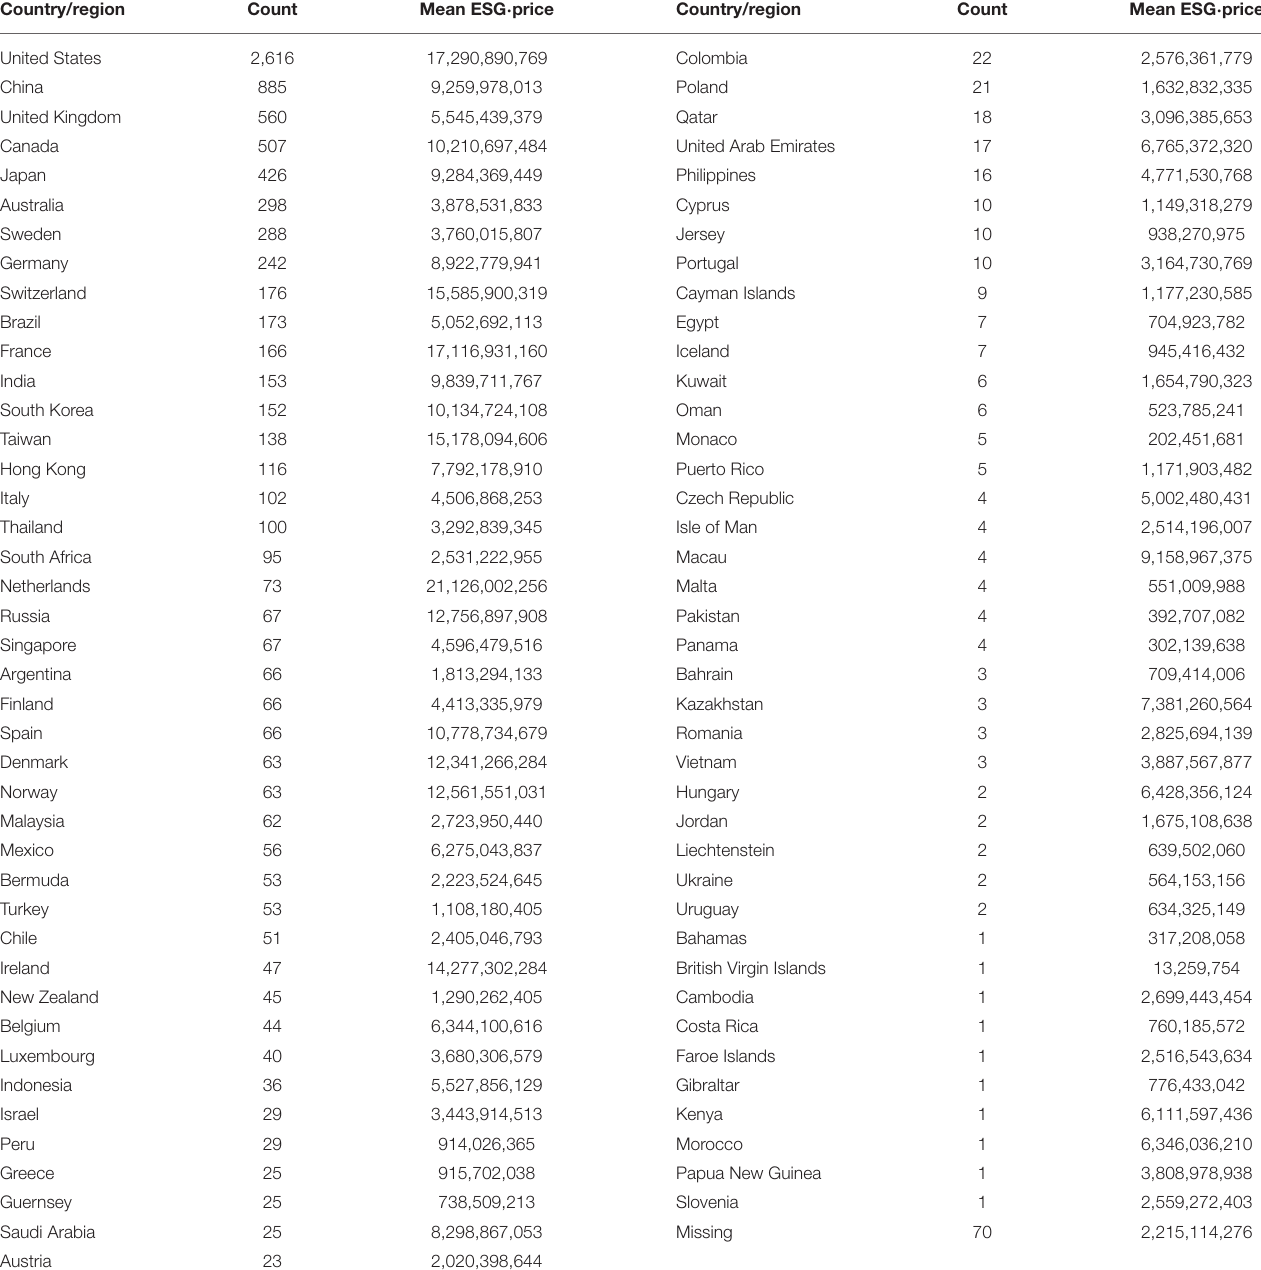
TABLE 1 | Summary of the ESG score multiplied with the total market price